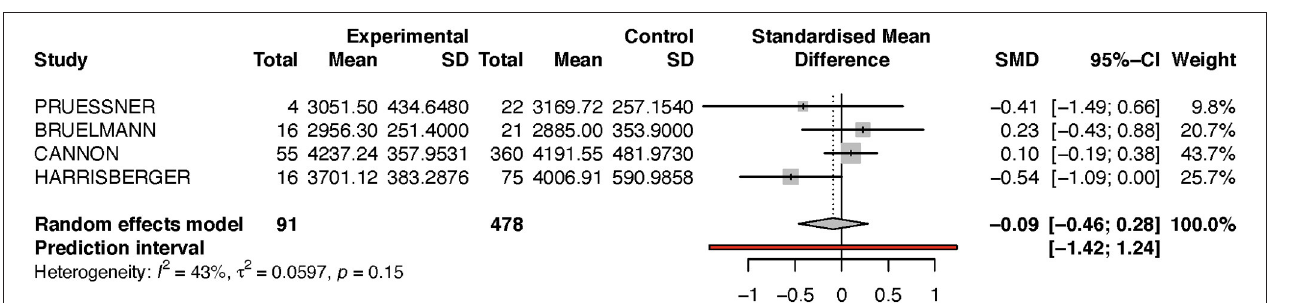
FIGURE 5 | Forest plot for Left hippocampus (sensitivity analysis). TABLE 3 | Univariable meta-regression including all studies. Right hippocampus Left hippocampus Estimate 95% CI p -value Estimate 95% CI p